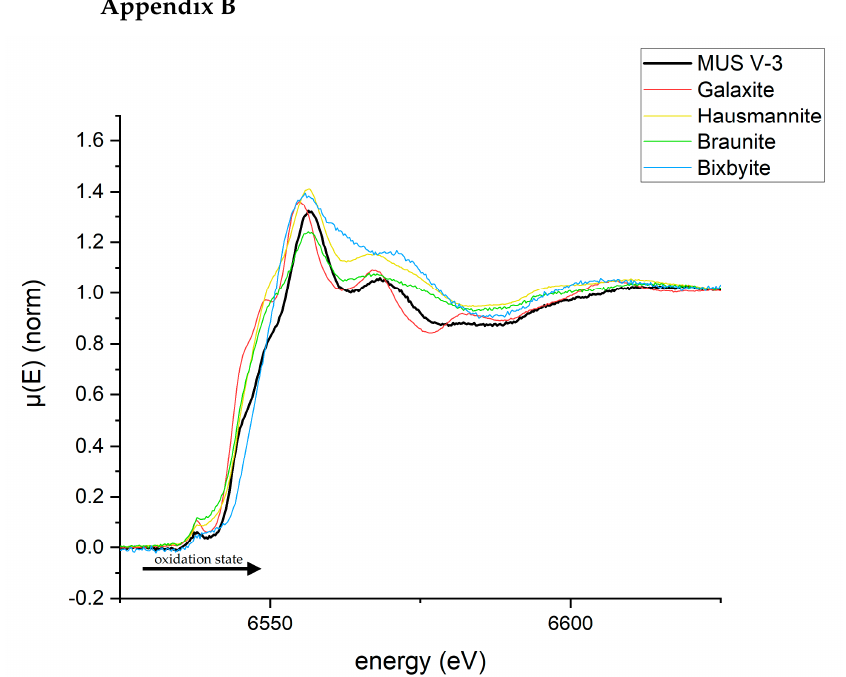
Figure A1. Spectra of Mn samples of different oxidation states. The spectra are compared to the measurement of the MUS. Oxidation states ranging for a better overview in contrast to Figure 6 from +2 to +3.